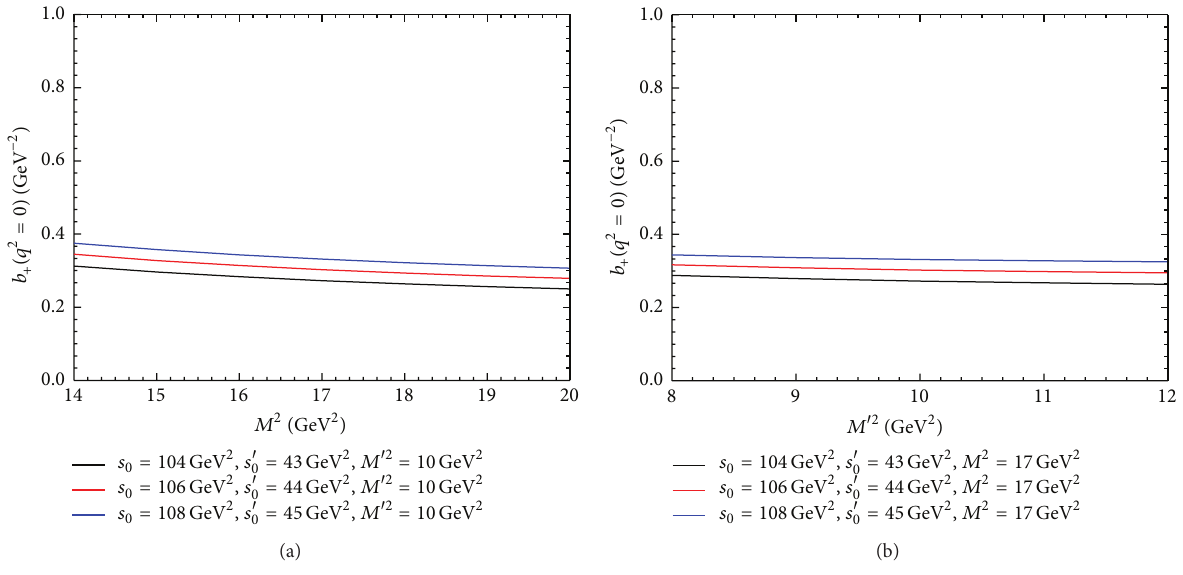
Figure 2: (a) 𝑏 + (𝑞 2 = 0) as a function of the Borel mass parameter 𝑀 2 at fixed values of 𝑠 0 , 𝑠 󸀠 0 , and 𝑀 󸀠2 . (b) 𝑏 + (𝑞 2 = 0) as a function of the Borel mass parameter 𝑀 󸀠2 at fixed values of 𝑠 0 , 𝑠 󸀠 0 , and 𝑀 2